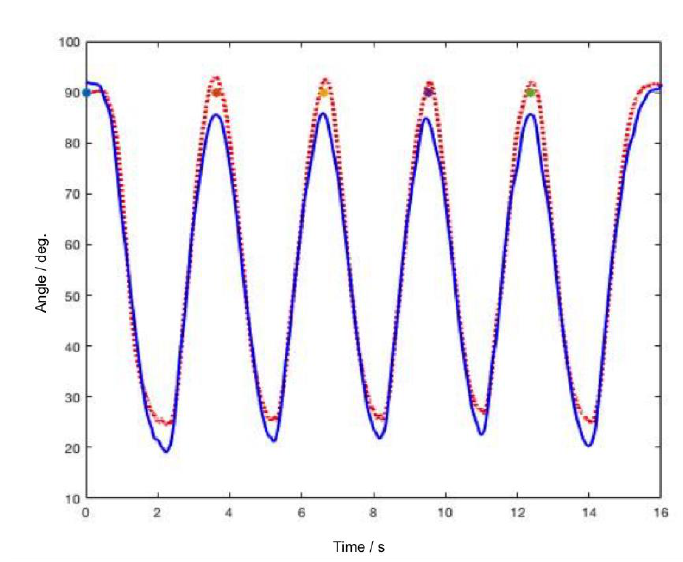
Figure 2. Raw data of five movement cycles in one of the tasks: BPMpathway (full blue line) and the BIOPAC goniometer (dotted red line).